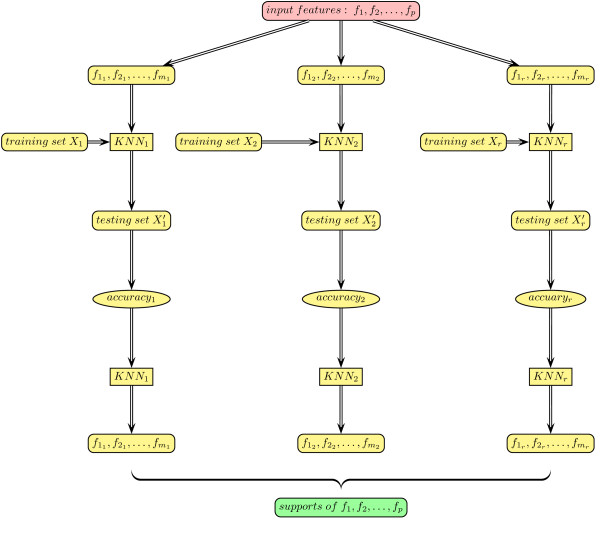
Bidirectional voting using Random KNN.